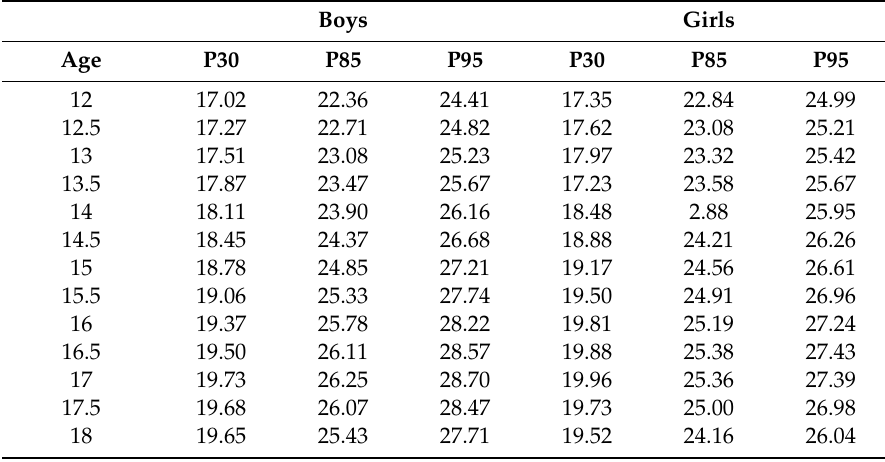
Table 1. Body mass index according to the subjects’ sex and